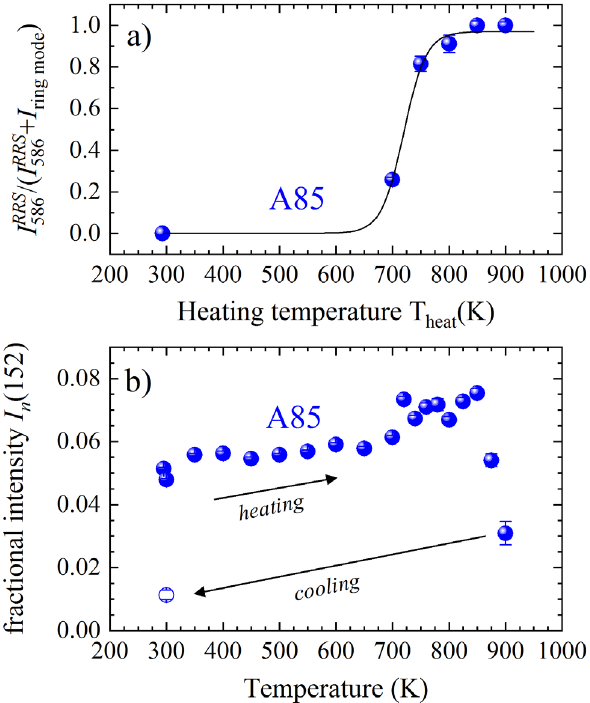
Fig. 5 Temperature dependence of the integrated intensity of selected peaks for grunerite A85. a Intensity ratio of the strongest RRS peak (~586 cm − 1 ) and the non-RRS peak generated by ring mode (~658 cm − 1 ) I RRS = ð I RRS þ I Þ , derived from the (cid:1) y 0 ð zz Þ y 0 spectra measured at room ring mode 586 586 temperature after heating in air to a certain temperature T heat ; the line is a Boltzmann fi t to the data points. b Fractional intensity I n of the